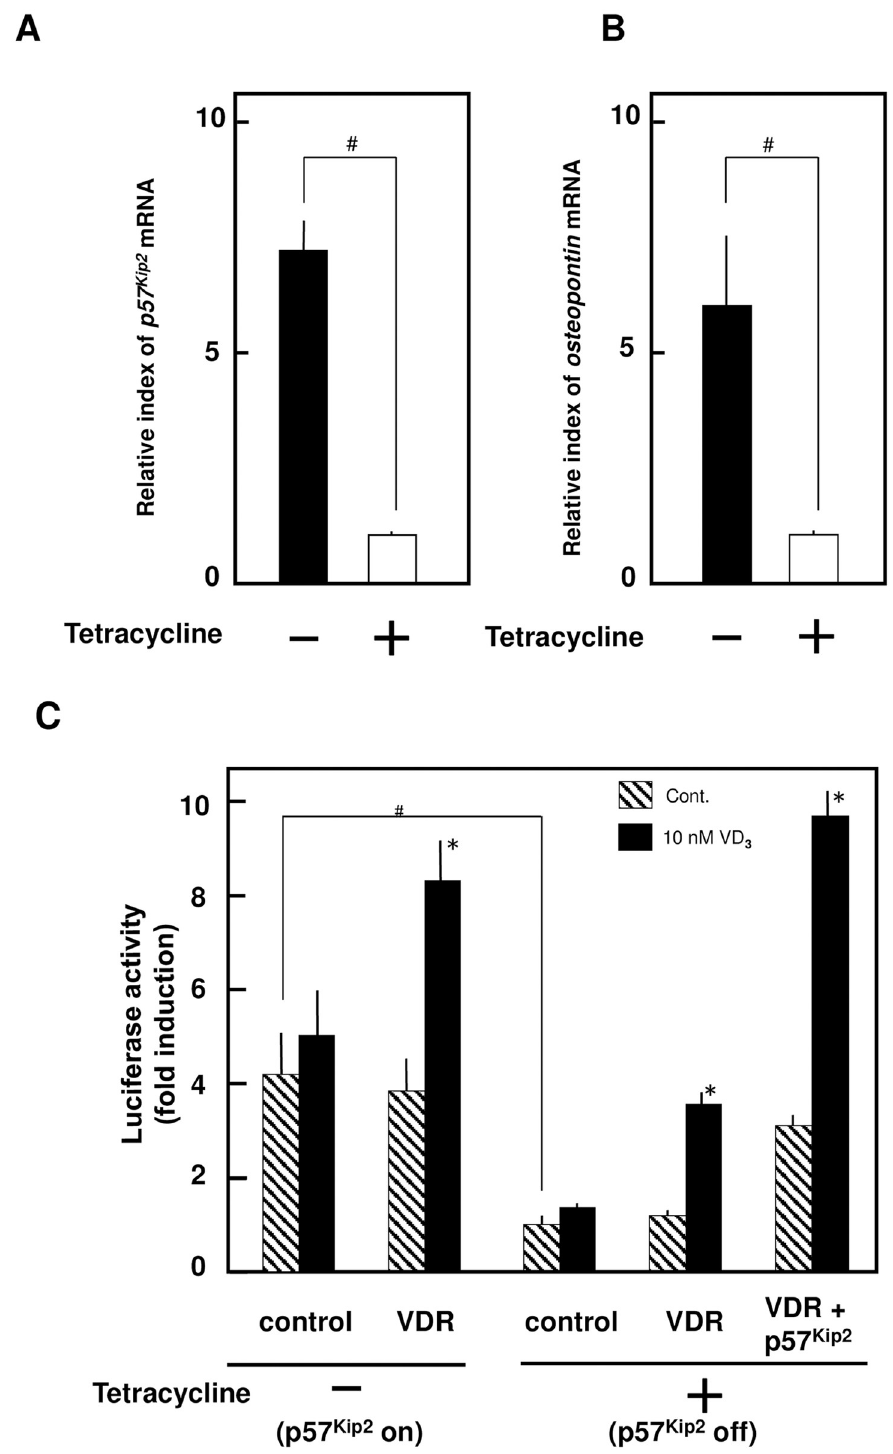
Fig 2. p57 Kip2 Upregulates the VD 3 -dependent expression of opn transcripts. Expression levels of both p57 Kip2 (A) and opn (B) depended on the presence of tetracycline in the SaOS2 tet-off p57 Kip2 transfectant. An asterisk indicates statistical significance: #, p < 0.01. (C) The activity of the opn promoter was estimated in SaOS2 tet-off p57 Kip2 - transfected cells. In the SaOS2 tet-off p57 Kip2 transfectant, p57 Kip2 expression (- tetracycline) upregulated opn promoter activity independently of 1,25-(OH) 2 VD 3 . Under equal transfection conditions, an asterisk indicates a